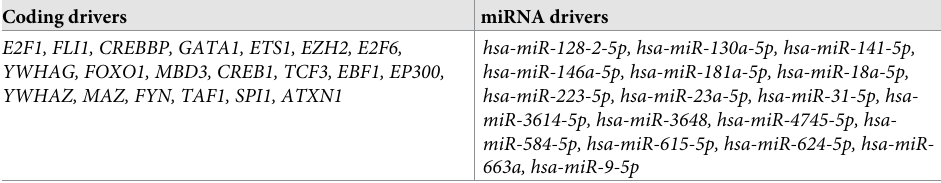
Table 4. Top 20 coding and 17 miRNA drivers predicted for EMT in breast